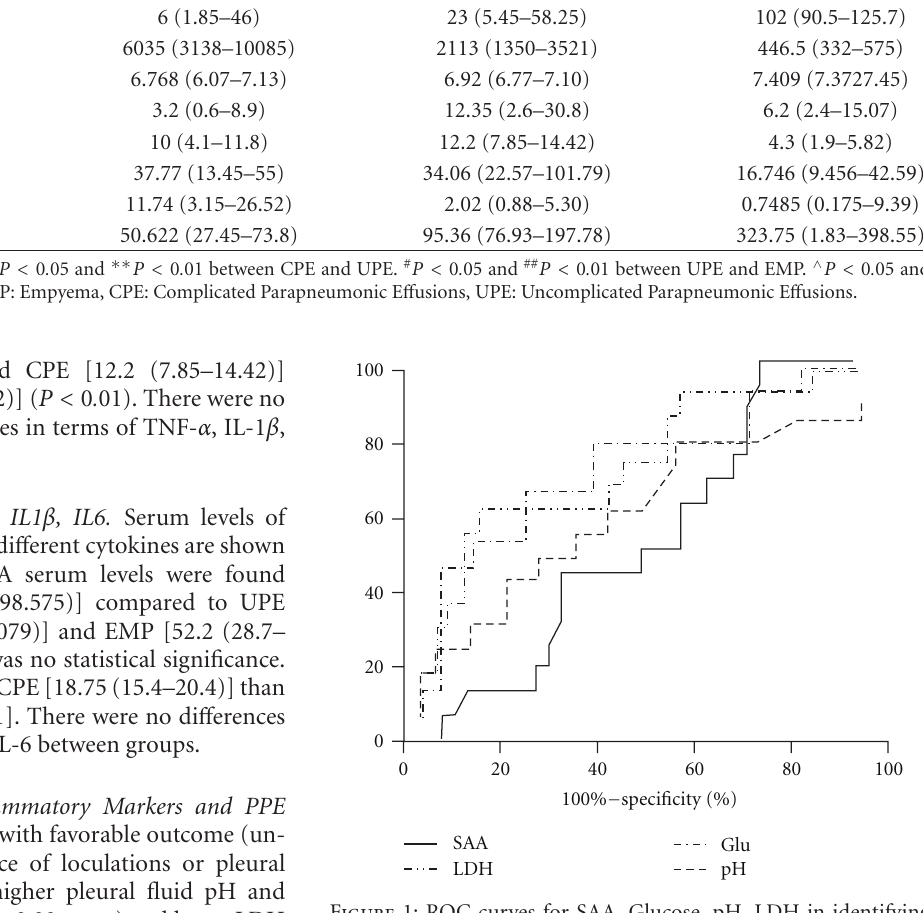
Figure 1: ROC curves for SAA, Glucose, pH, LDH in identifying PPE patients with favourable course and outcome at 6